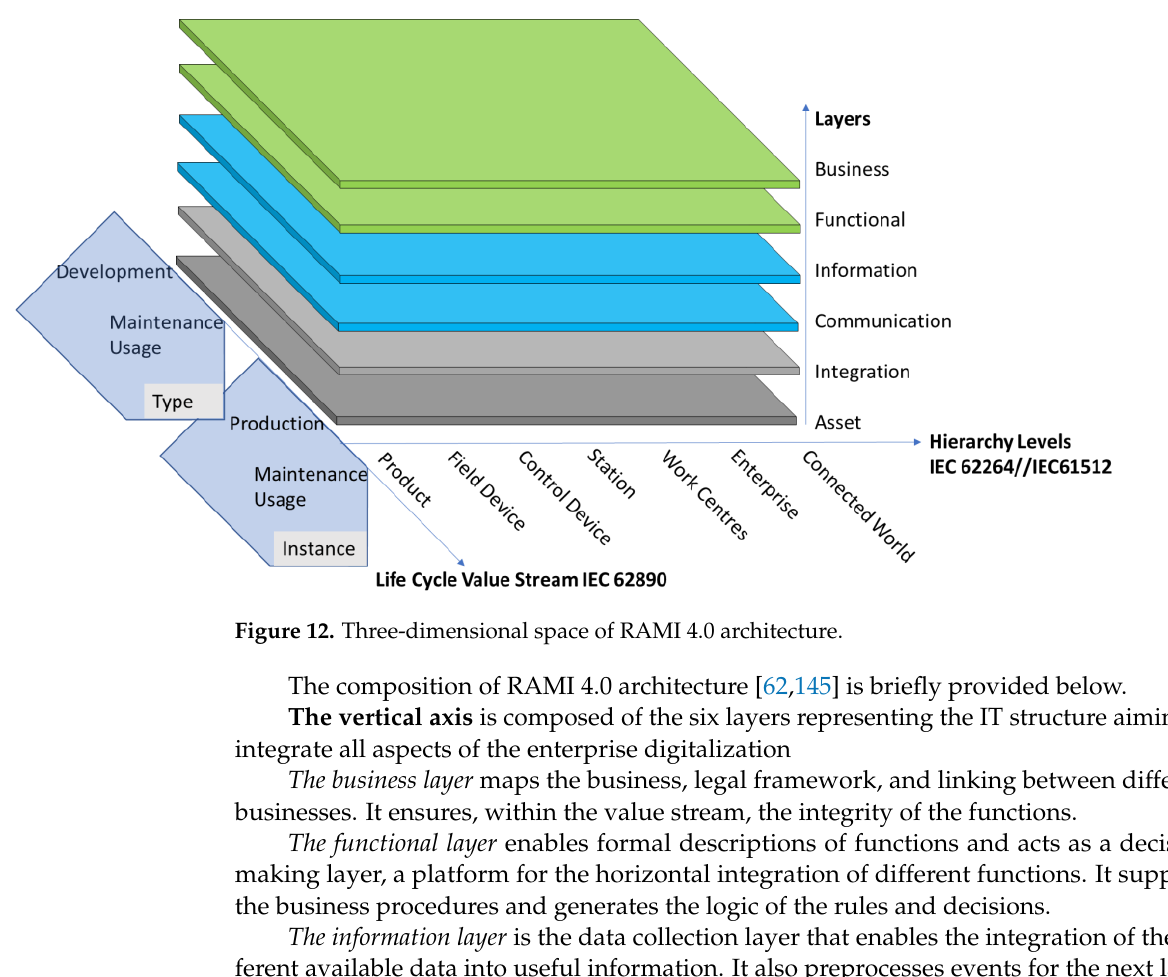
Figure 12. Three-dimensional space of RAMI 4.0 architecture.